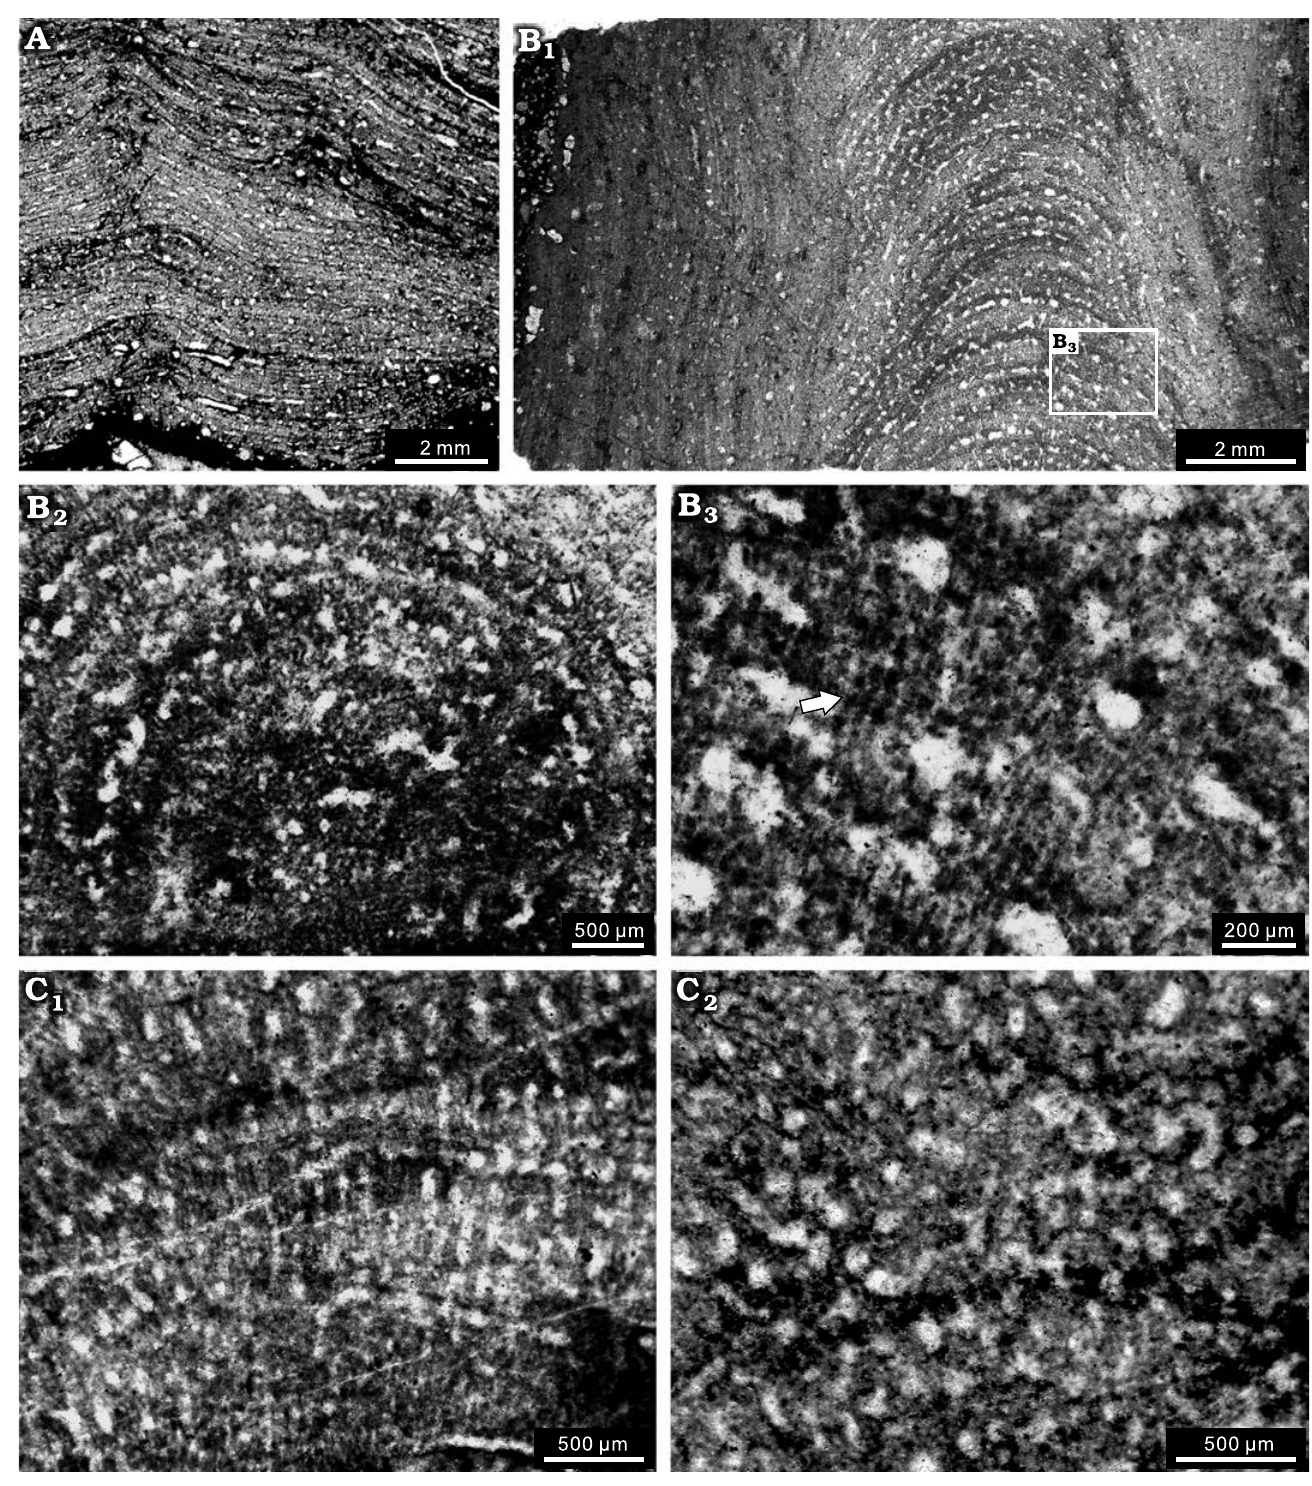
Fig. 9. Stromatoporoids from the Jiwozhai reef, Jiwozhai Member, Dushan Formation, Givetian, Middle Devonian; Dushan, Guizhou, South China. A , B . ? Habrostroma laminosum (Lecompte, 1952) A . NIGP 177055; longitudinal section of the laminar form; B . NIGP 177056; B 1 , longitudinal section of the high domical form; B 2 , poor preservation of tangential section showing the dense structure; B 3 , enlargement of B 1 , showing possible microreticu- late microstructure (arrow). C . Parallelopora sp., NIGP 177057; C 1 , longitudinal section, note the microreticulate microstructure; C 2 , tangential section showing the autotubes. Fig. 10. Stromatoporoid Stachyodes costulata Lecompte, 1952, from the Jiwozhai reef, Jiwozhai Member, Dushan Formation, Givetian, Middle Devonian; Dushan, Guizhou, South China. A . NIGP 177058; A 1 , longitudinal section of the whole thin section showing the columnar skeleton interconnected through